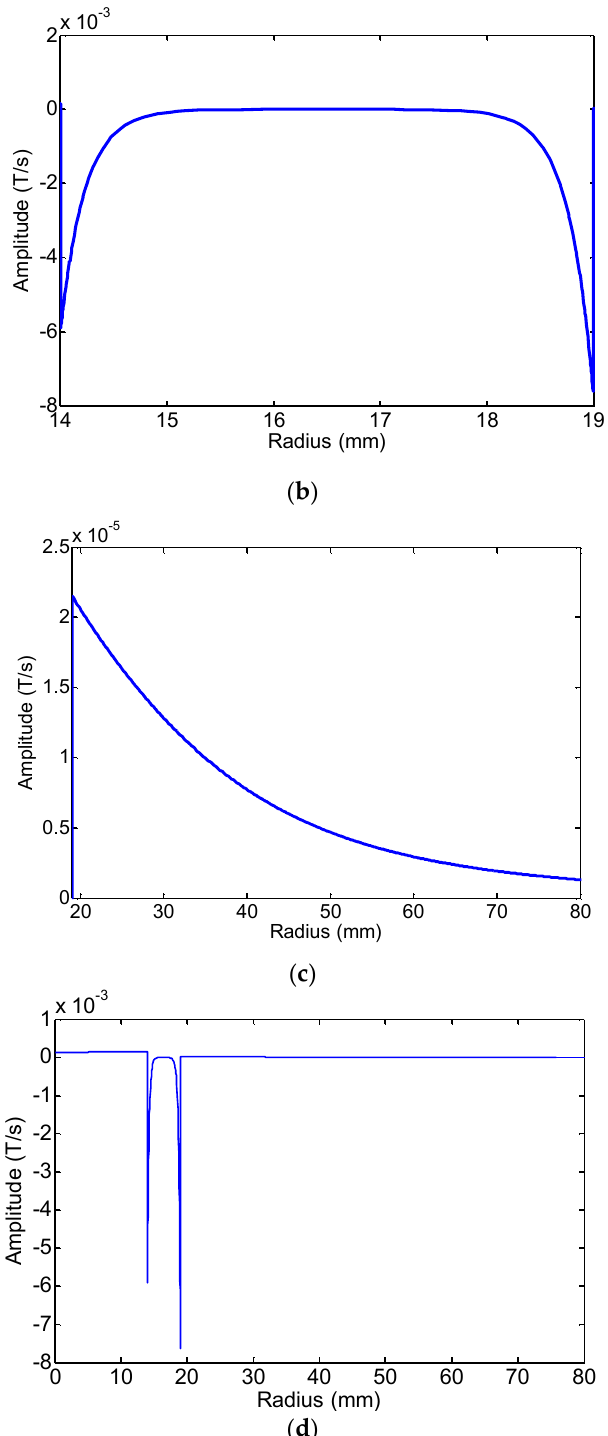
Figure 6. The FE calculation results of the changing rate of magnetic flux density in the radial direction at 20 kHz: ( a ) the internal air zone; ( b ) the pipe wall; ( c ) the external air zone; ( d ) the 0–80 mm zone.